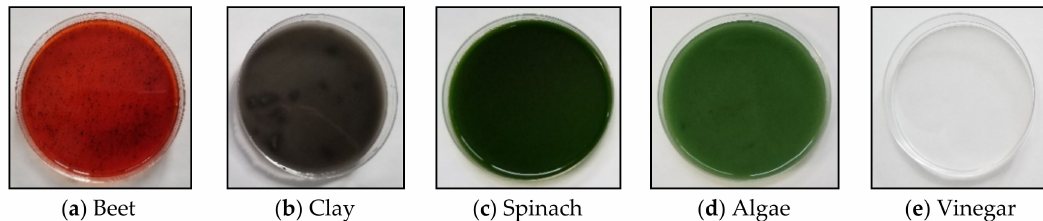
Figure 8. Samples of insoluble and soluble matters considered in the experiments: ( a ) beet powder, ( b ) clay, ( c ) spinach, ( d ) algae, and ( e ) vinegar,